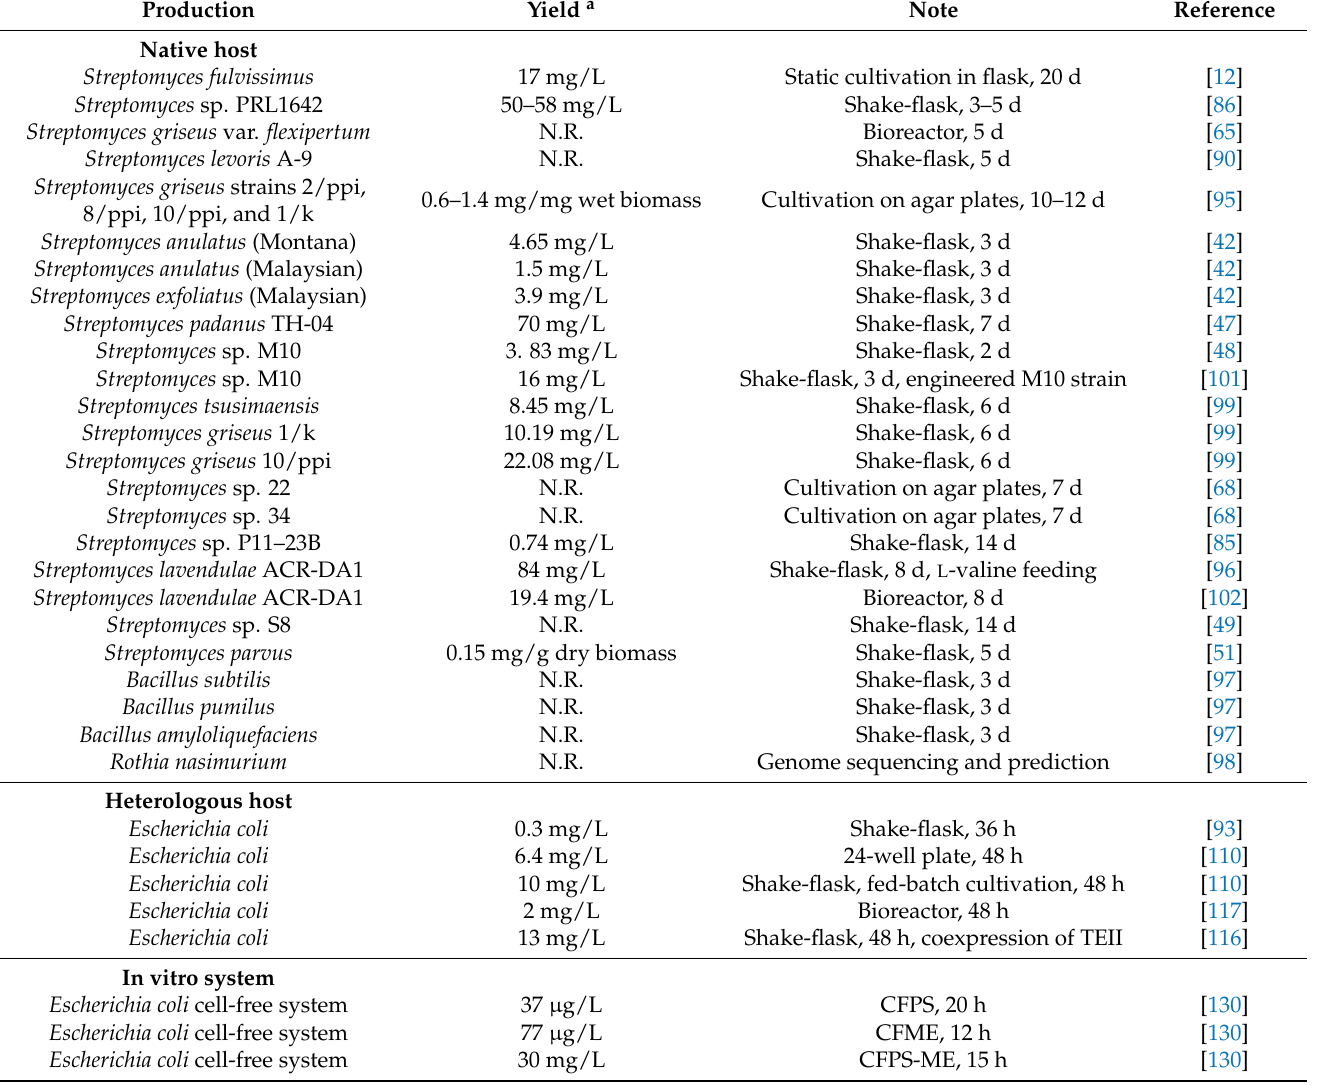
Table 2. Production levels of valinomycin with native and heterologous